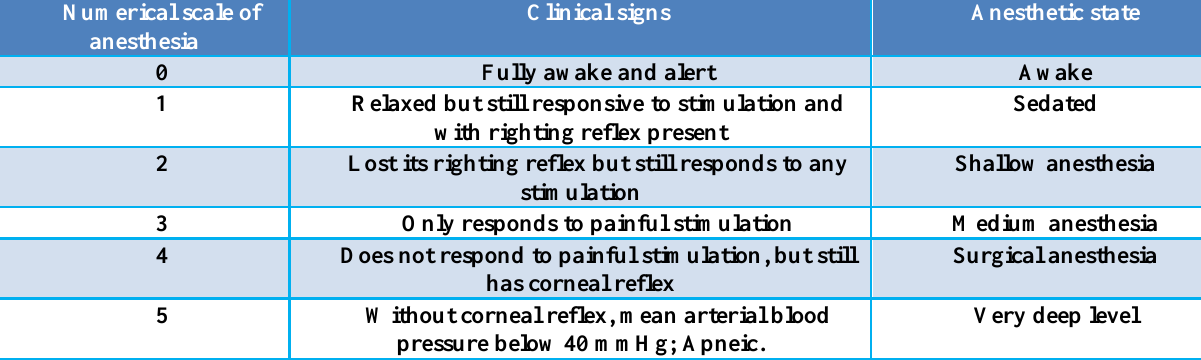
Sedated Shallow anesthesia Surgical anesthesia Very deep